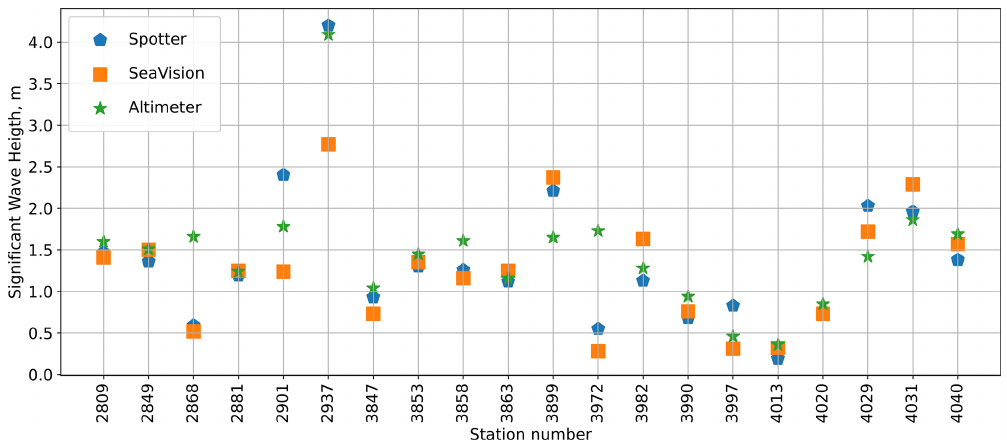
Figure 9. Significant wave height estimates for the locations of satellite altimeter overpasses for three research cruises. Numbers on the horizontal axis correspond to the station numbering in Table